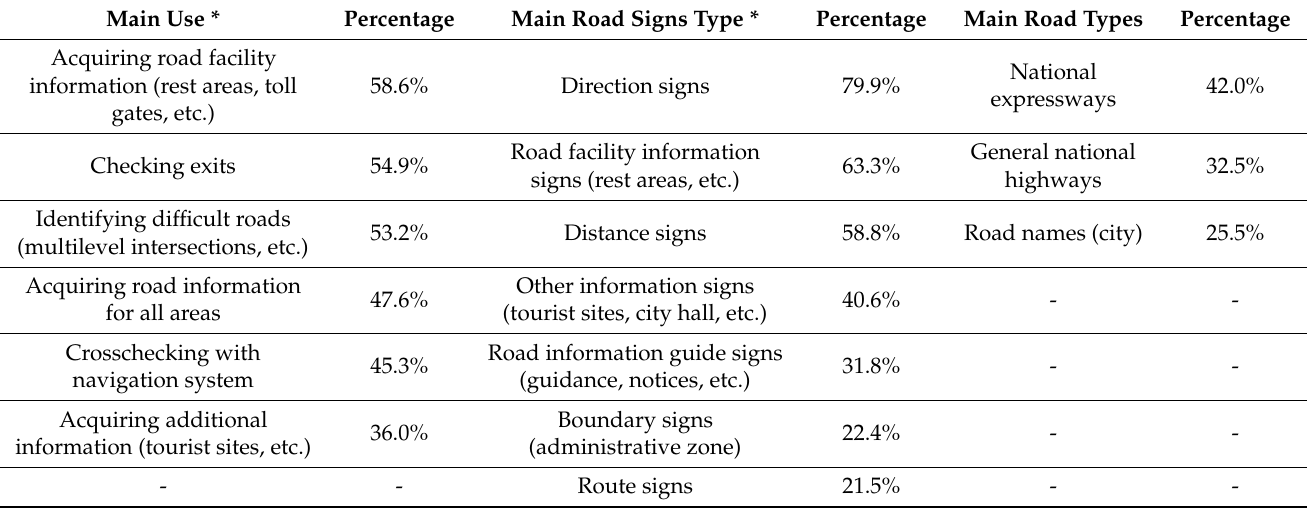
Table 3. Road sign usage states.